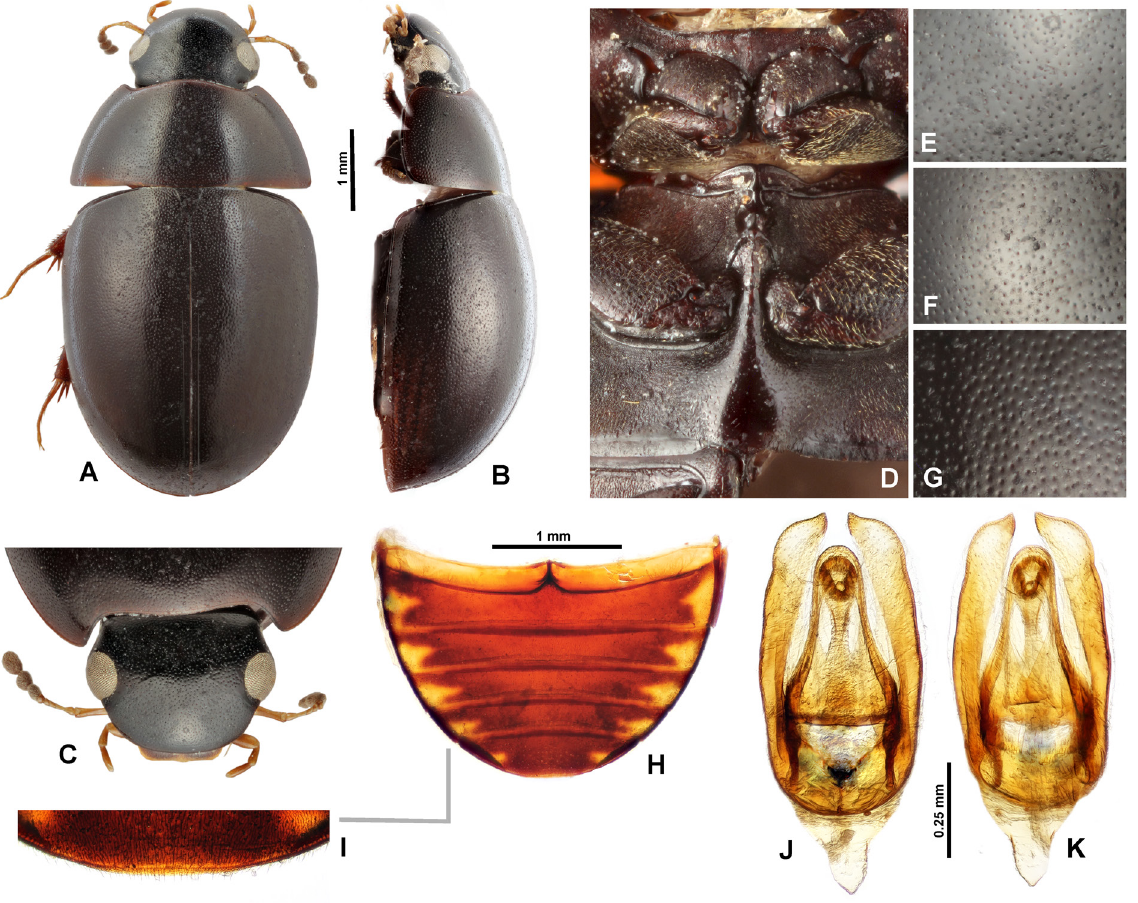
Fig. 4. Coelostoma (s. str.) fallaciosum Orchymont, 1936, ♂ specimen from India: Fatepur Sikri (NMPC). A . Dorsal habitus. B . Lateral habitus. C . Head in dorsal view. D . Thorax in ventral view. E . Dorsal punctation of head. F . Dorsal punctation of pronotum. G . Dorsal punctation of elytron. H . Abdominal ventrites. I . Detail of abdominal apex. J–K . Aedeagus: ventral (J) and dorsal